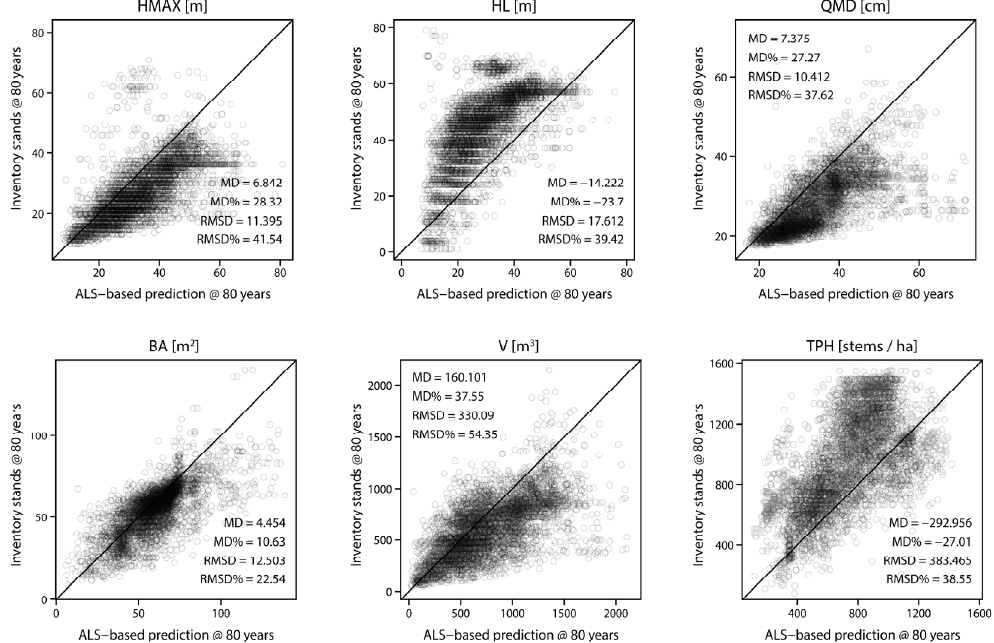
Figure 7. Comparison of six chosen forest stand attributes projected to 80 years at stand-level. Observed values are derived by projecting stand attributes, whereas predicted values are derived with the proposed method and averaged to stand level.